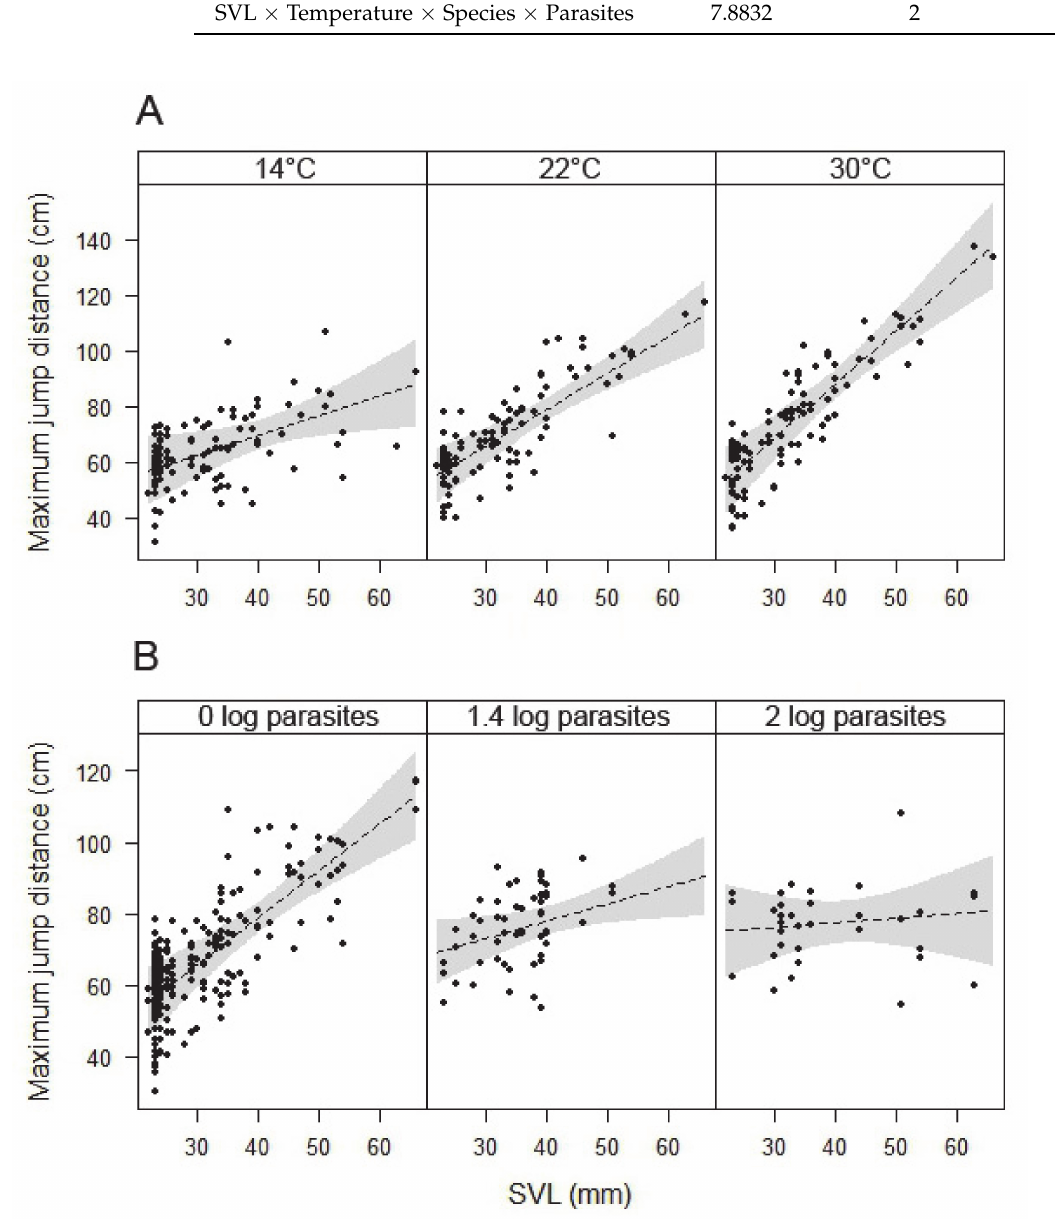
Figure 3. Interactive effects of ( A ) snout-vent length (SVL) and temperature and ( B ) SVL and log 10 parasite load on the maximum jumping distance of frogs. These plots are conditional plots with fitted regression line (dotted line), partial residuals (dots), and 95% confidence bands (shaded) that control for all factors in the statistical model that are not shown in the figure (see Table